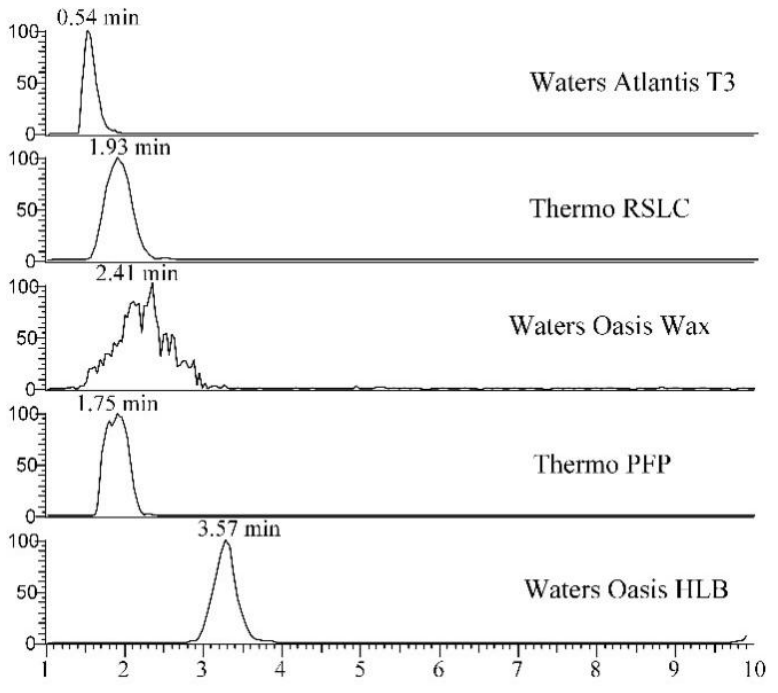
Figure A1. The retention time of NDMA on five columns in 100% pure water.